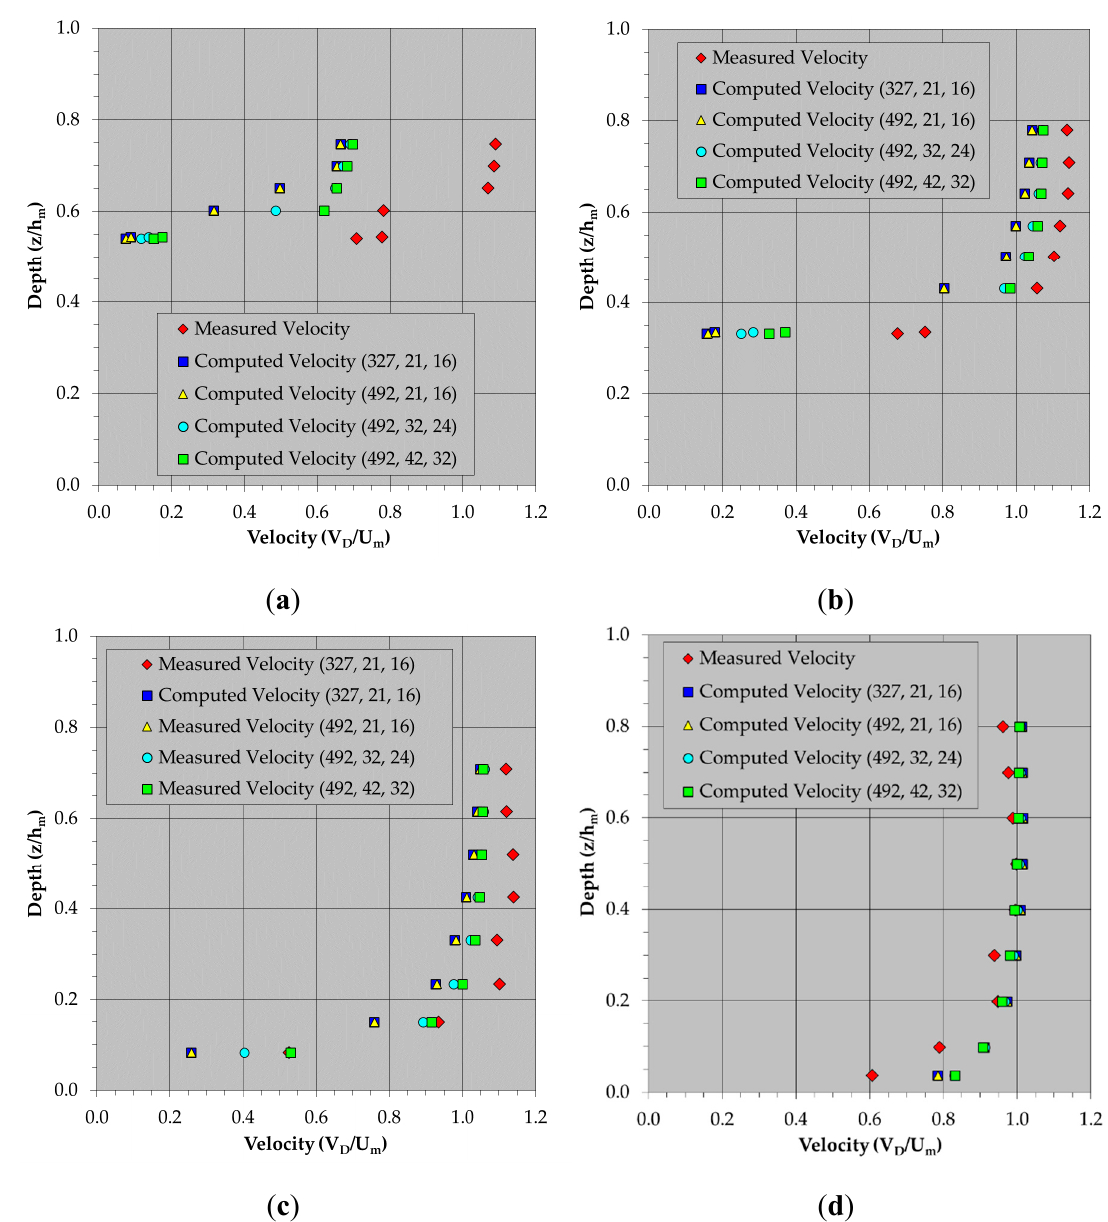
Figure A15. Cont